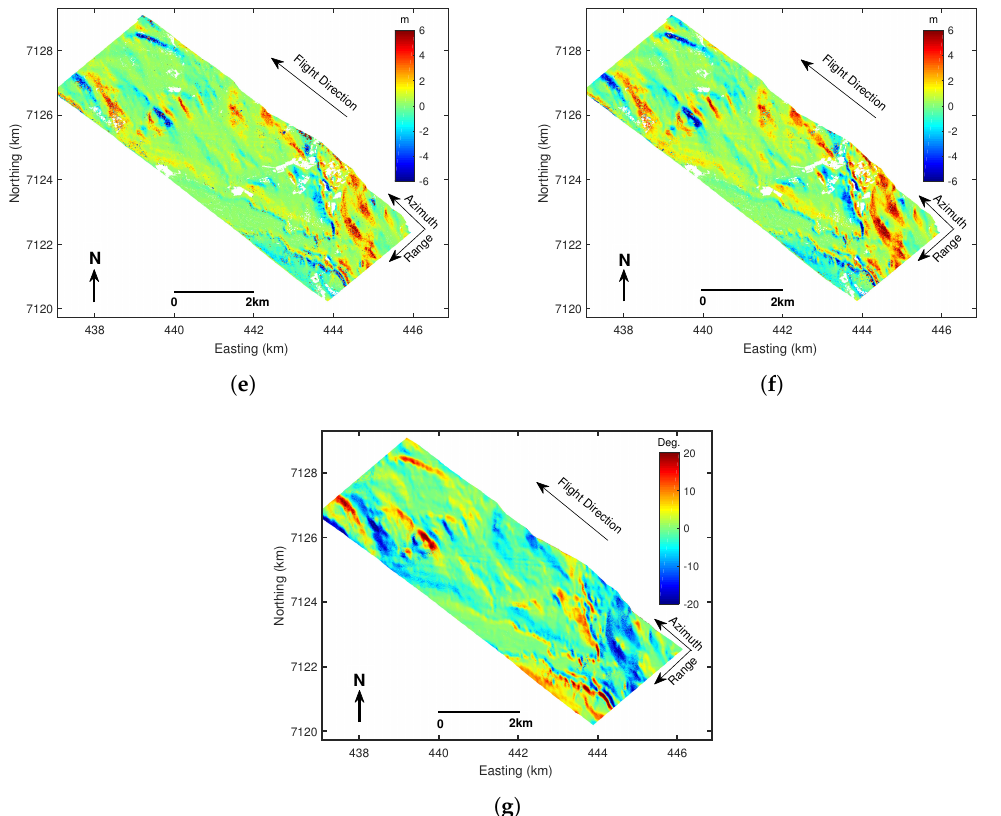
Figure 8. The forest height estimation with ( a ) RVoG model + three-stage method, ( b ) RVoG model + modified three-stage method (time-frequency optimization), ( c ) S-RVoG model + three-stage method, and ( d ) S-RVoG model + modified three-stage method (time-frequency optimization). ( e , f ) The difference values after terrain compensation corresponding to Figure 8a,c and Figure 8b,d, respectively. ( g ) The range terrain slope.